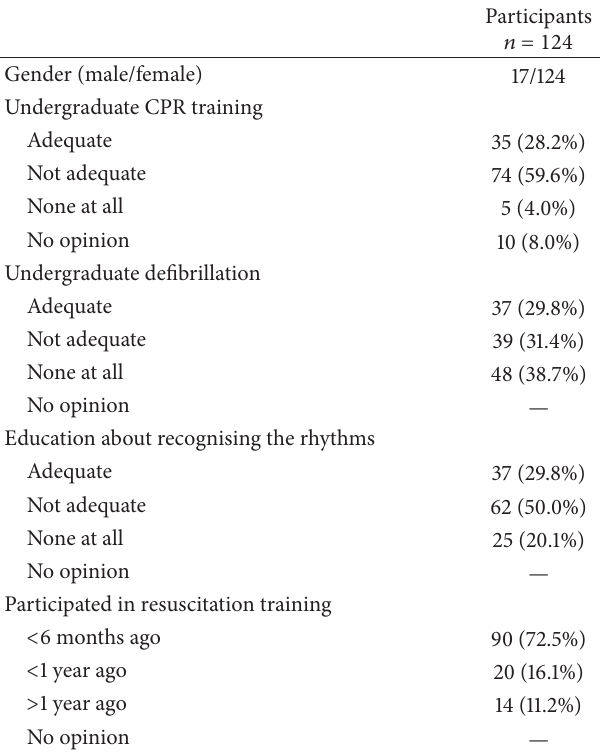
Table 4: CPR training of the respondents. A questionnaire was distributed to CPR trainers attending two seminars. Figures are presented as numbers or as percentage.